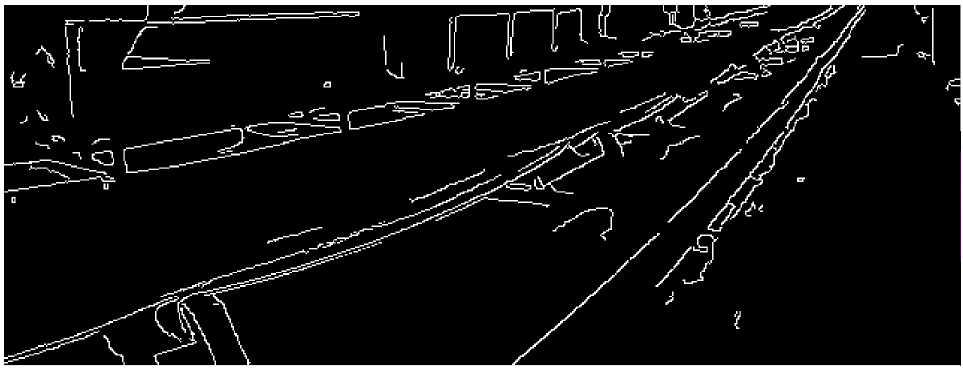
Figure 6. Exemplary effect of applied Canny filter.